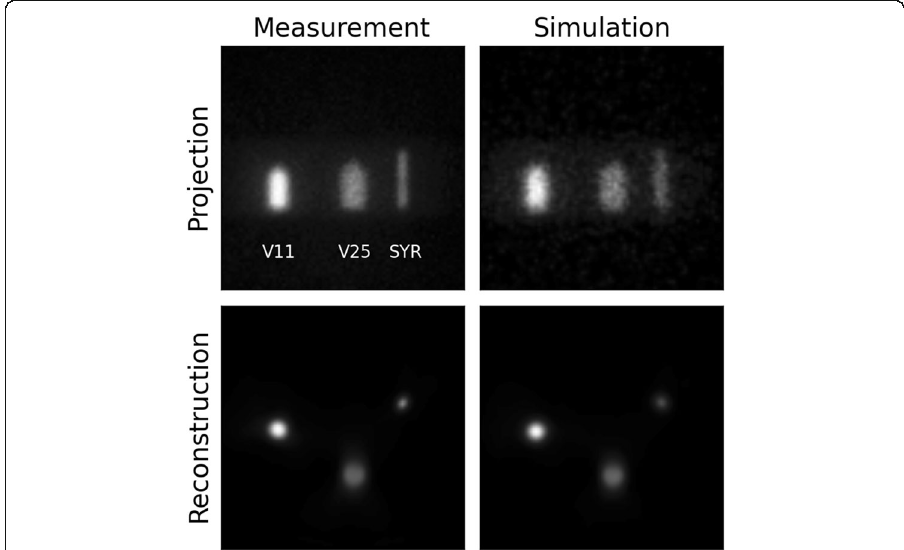
Fig. 10 Tomographic images. Comparison of measured and simulated acquisitions in tomographic setup: top row: geometric means of the anterior and posterior projections; bottom row: SPECT reconstructions of central axial